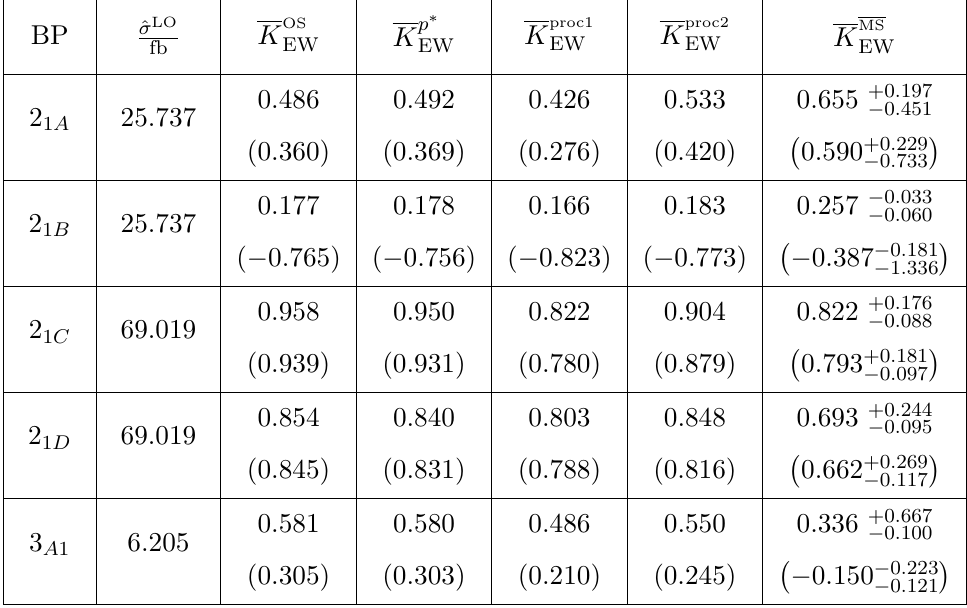
H h for the 2HDM benchmark ! ((cid:12)rst value) EW